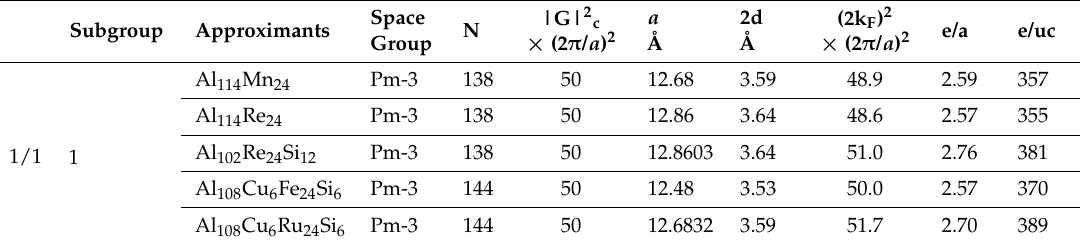
Table 5. Hume-Rothery electron concentration rule for MI-type 1/1-1/1-1/1